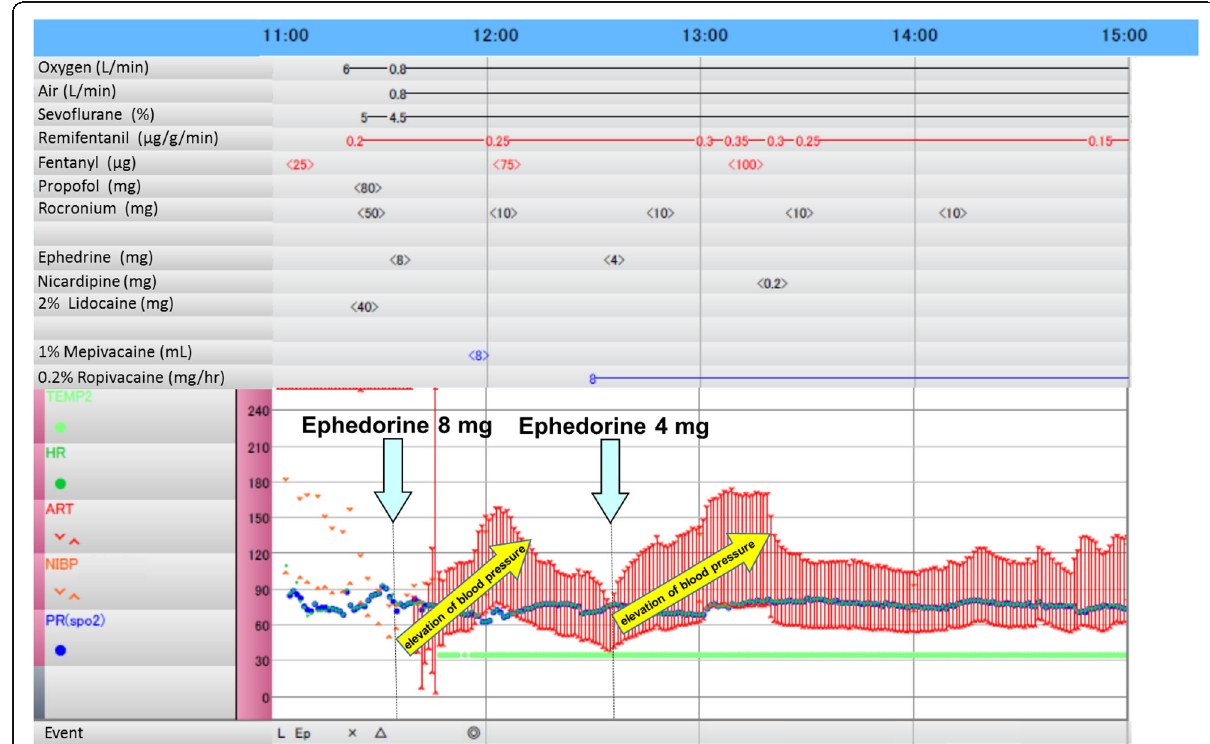
Fig. 1 The patient ’ s anesthesia chart. Small amounts of ephedrine (8 or 4 mg) reproducibly induced large increases in blood pressure, and treatment with nicardipine, a calcium channel blocker, was required to suppress the second blood pressure